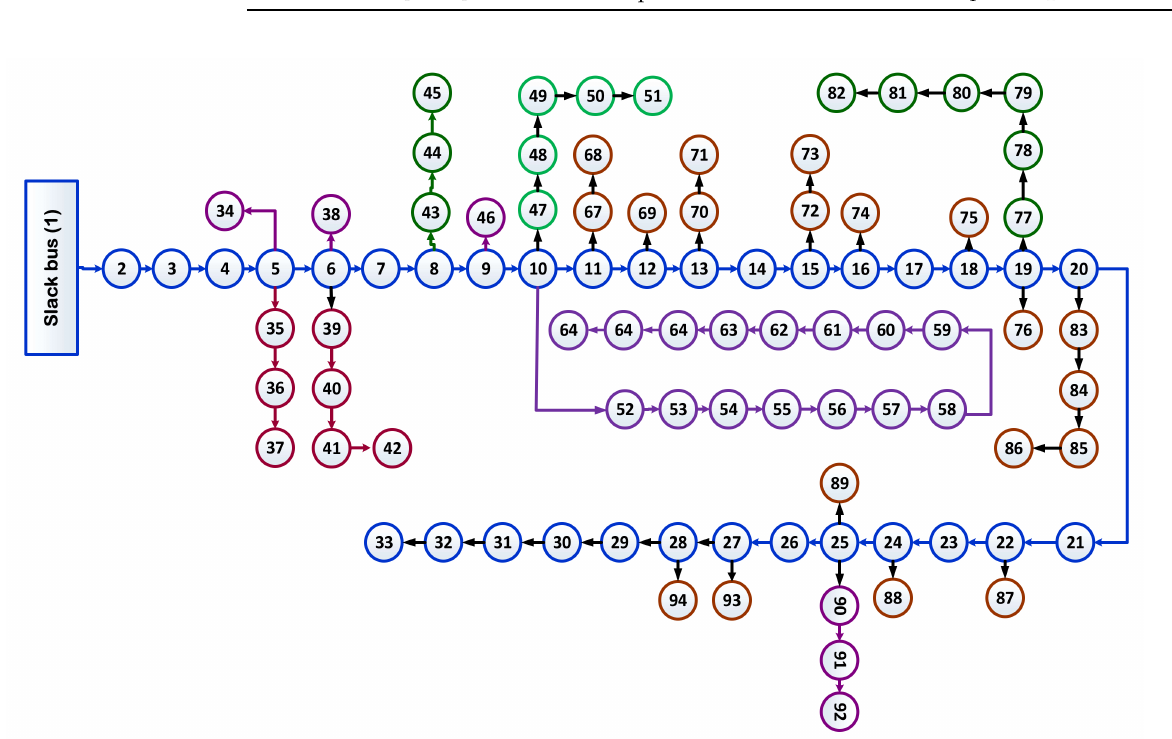
Figure 2. The configuration of the 94 bus